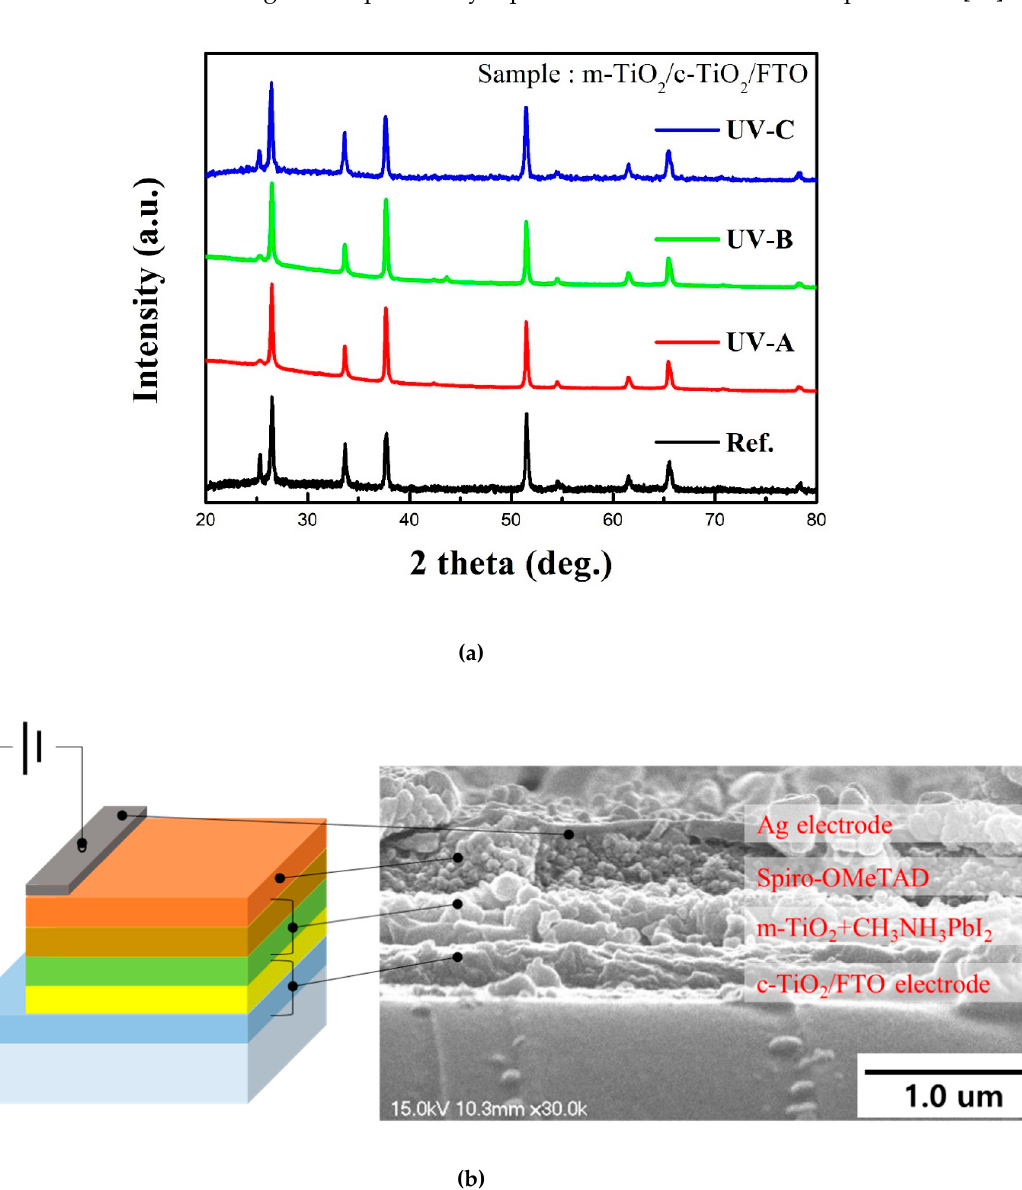
Figure 4. ( a ) X-ray diffraction (XRD) patterns of m-TiO 2 /c-TiO 2 /FTO substrate and ( b ) cross-sectional field-emission scanning electron microscopy (FE-SEM) image of fabricated perovskite solar cells (PCSs) after UV-C light surface treatment.